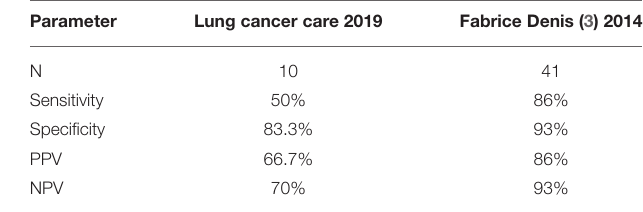
TABLE 3 | Relationship between PD by imaging and patient-reported outcome (PRO) score (tool performances analysis). Suspicion of PD by tool